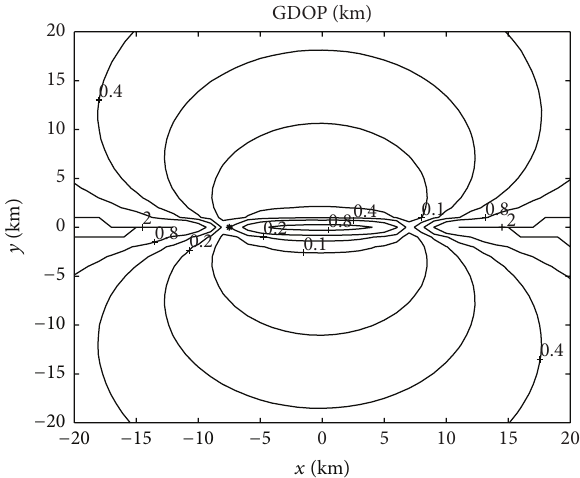
Figure 4: Spatial distribution of double-station array buoy two- dimensional target positioning error.